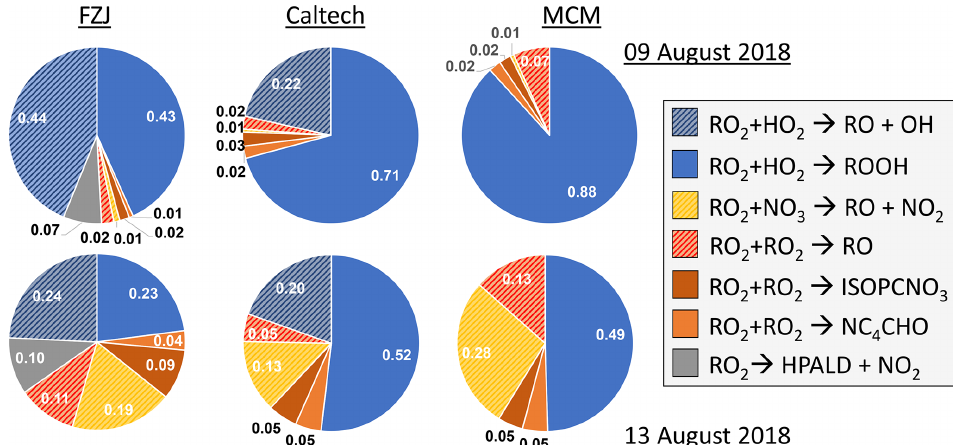
Figure 7. Relative distribution of loss rates of nitrate RO 2 for the experiment on 9 August 2018 (Experiment 1), when HO 2 concentrations were enhanced, and for the experiment on 13 August 2018 (Experiment 4), when the amount of oxidized isoprene was highest. The total RO 2 loss rate was 0.035 and 0.014s − 1 in the experiments on 9 August 2018 (Experiment 1) and 13 August 2018 (Experiment 4), respectively. Calculations of the loss rates of RO 2 radicals in bimolecular reactions make use of measured HO 2 and NO 3 concentrations. Total RO 2 concentrations and concentrations of speciated nitrate RO 2 were derived from model calculations applying the FZJ-NO3 mechanism, Caltech mechanism or MCM. The chemical mechanisms differ with respect to the number of nitrate RO 2 isomers that are considered, the type of RO 2 loss reactions and products of loss reactions (Figs. 3 and 6). Reactions leading to nitrate alkoxy radicals are indicated by a striped